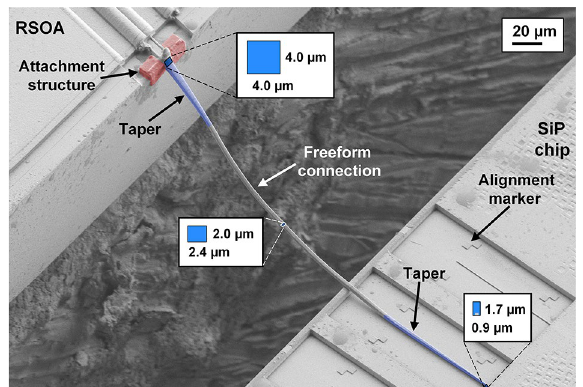
Figure 4. False-colored SEM picture of the fabricated PWB between the InP RSOA and the SiP external feedback circuit. The fabricated cross-section in each part of the PWB is indicated. On the InP side, a taper (blue) is used to transform the mode field on the RSOA facet to that of the freeform PWB connection. At the SiP chip, a polymer-to-silicon double-taper transition 22,23 is used for efficient connections. The blue rectangles indicate the cross sections at the respective positions along the PWB trajectory. An additional attachment structure (red) is added on the RSOA facet for mechanical stability. Alignment markers on the SiP chip facilitate exact localization of the coupling interface.